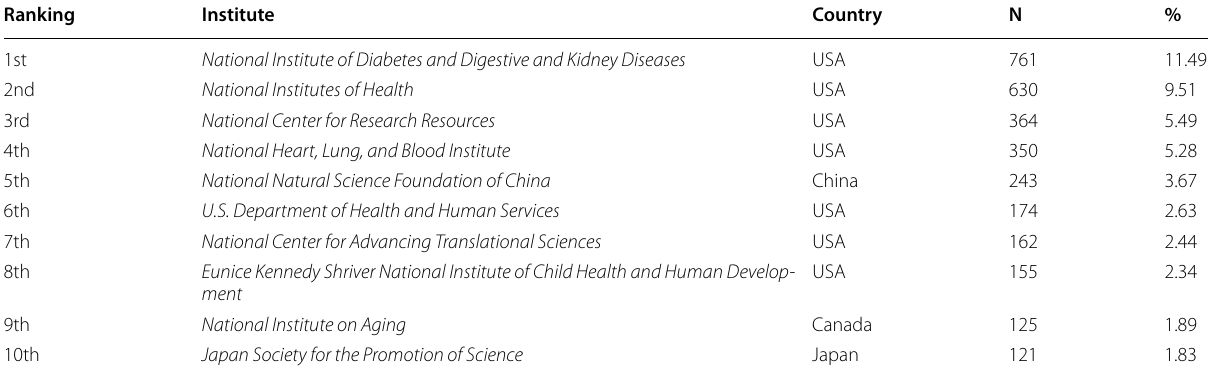
Table 2 The top ten funding agencies having the most publications on insulin resistance and obesity from 2002 to 2021 Ranking